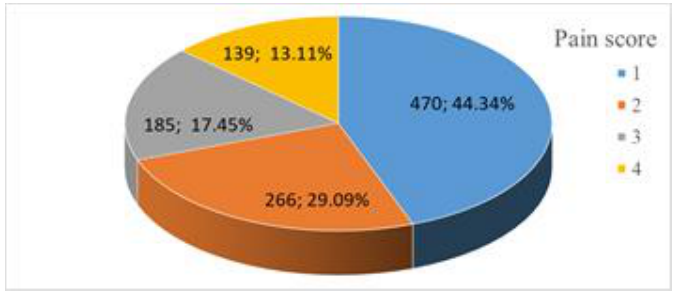
Figure 5. Pain score distribution.